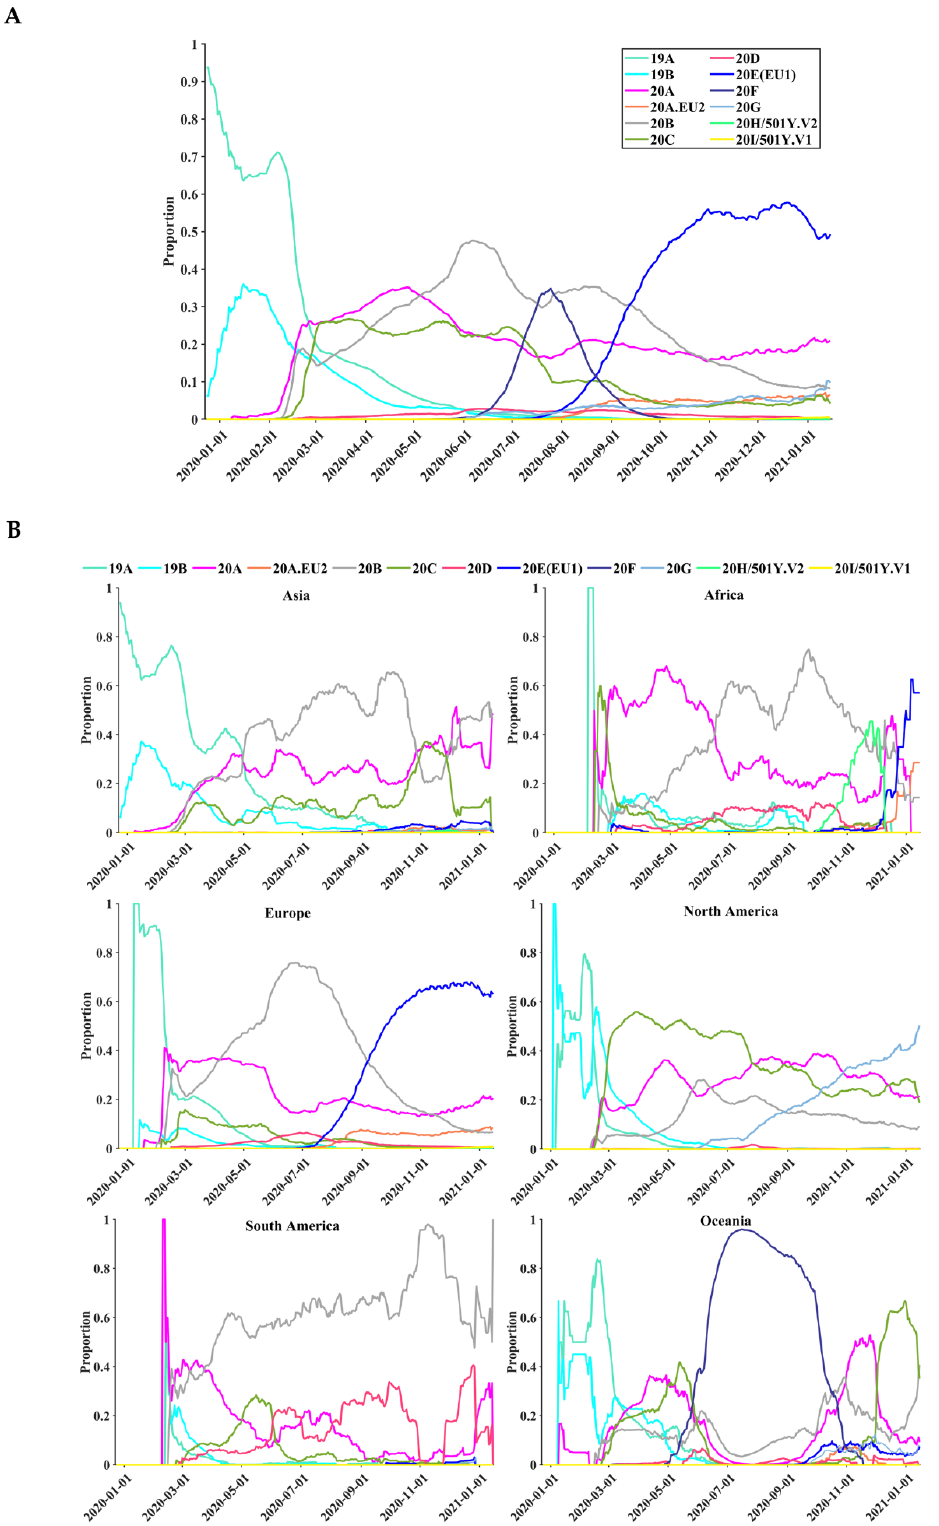
Figure 7. Temporal distributions of the 12 clades based on 260,673 complete SARS-CoV-2 nucleotide sequences. ( A ) The global distribution of the 12 clades over time. ( B ) The distribution of the 12 clades over time on six continents. The vertical axis represents the moving-window proportion, calculated by dividing the number of sequences belonging to a specific clade, 15 days before and after a specific date, by the total number of sequences in the period (31